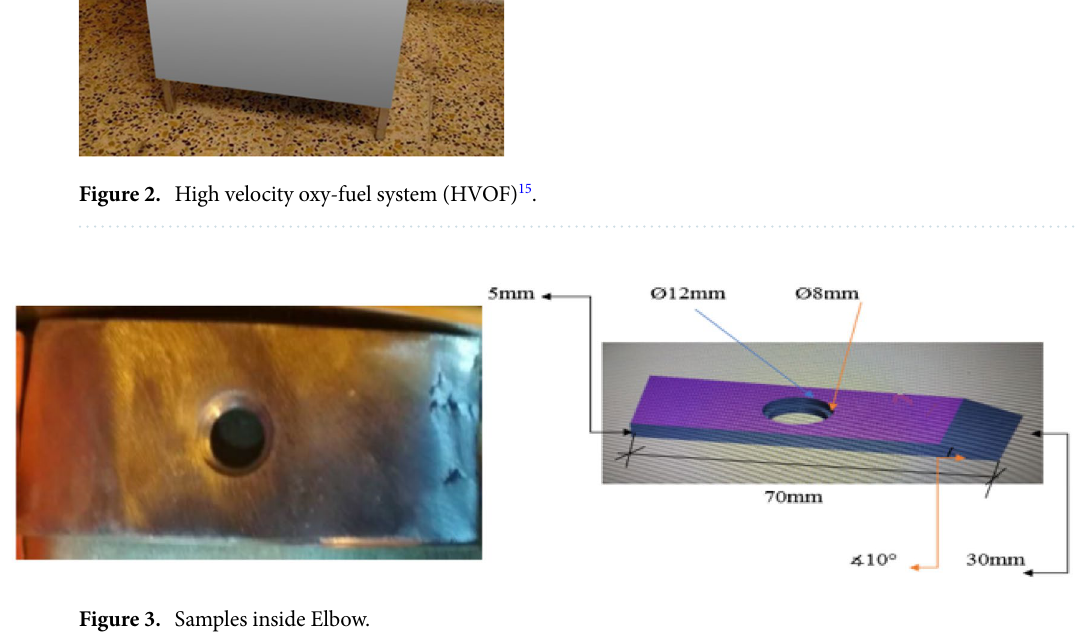
Figure 3. Samples inside